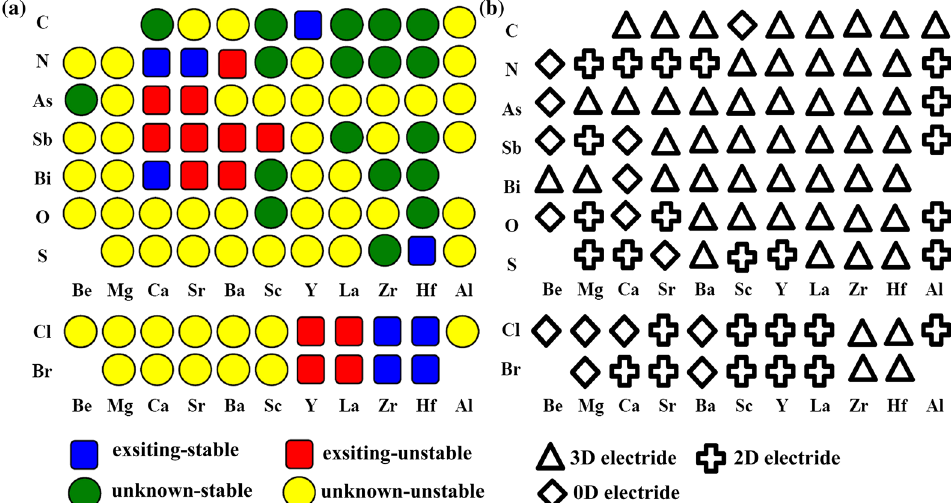
FIG. 4. Inverse-design results for binary electrides. (a) Stability map of A 2 B (top) and AB (bottom) ( A , electron donor; B , electron acceptor) electrides. A and B elements are shown in horizontal and vertical directions, respectively. Stable electrides are pointed to the electride structures with negative formation energies in their lowest-energy states, i.e., the thermodynamically most stable states, while metastable electrides are those either not in the lowest-energy states or having positive formation energy. Blue and red squares indicate stable and metastable existing compounds, respectively. Green and yellow circles indicate stable and metastable compounds yet to be synthesized, respectively. (b) Type map of A 2 B (top) and AB (bottom) electrides. Triangles, crosses, and diamonds indicate 3D, 2D, and 0D electrides, Fig. 4(a) for taking the consideration of experimental